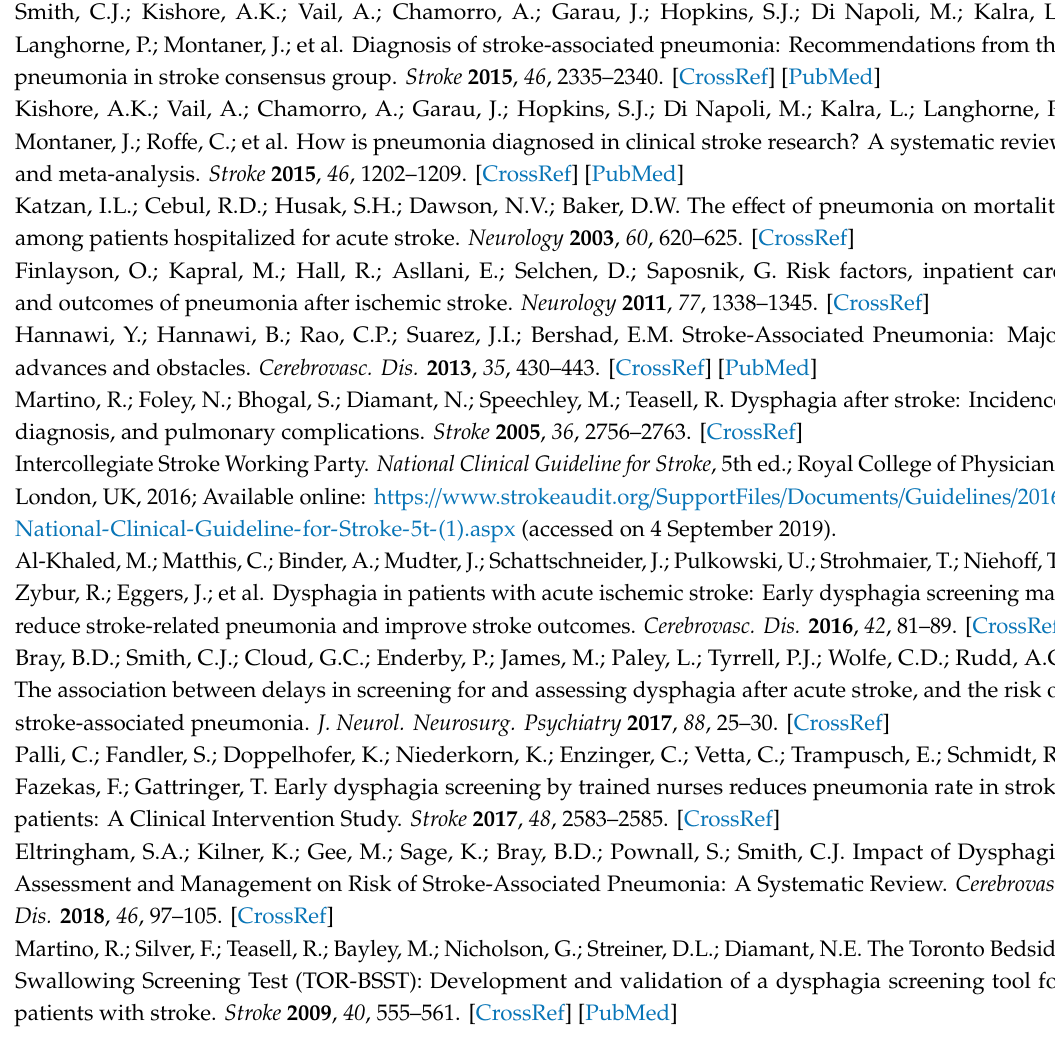
Table S1: Summary of Royal College of Physicians Clinical Guideline for Stroke (2016), Table S2: Topic Guide for Sta ff Interviews; Table S3: Participant Characteristics; Table S4: Type of Dysphagia Screening Protocol; Table S4: Standards for Reporting Qualitative Research